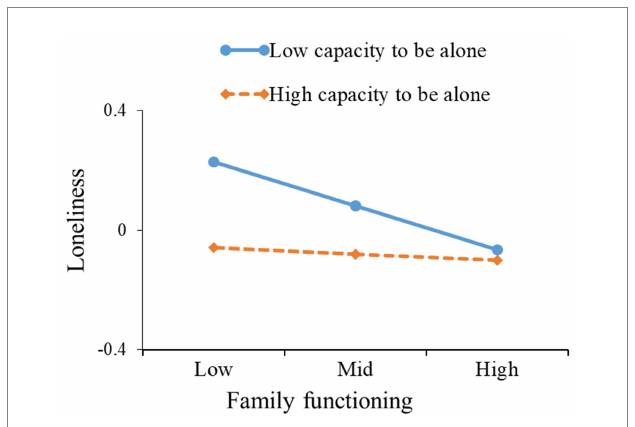
FIGURE 3 The capacity to be alone moderates the relation between family functioning and